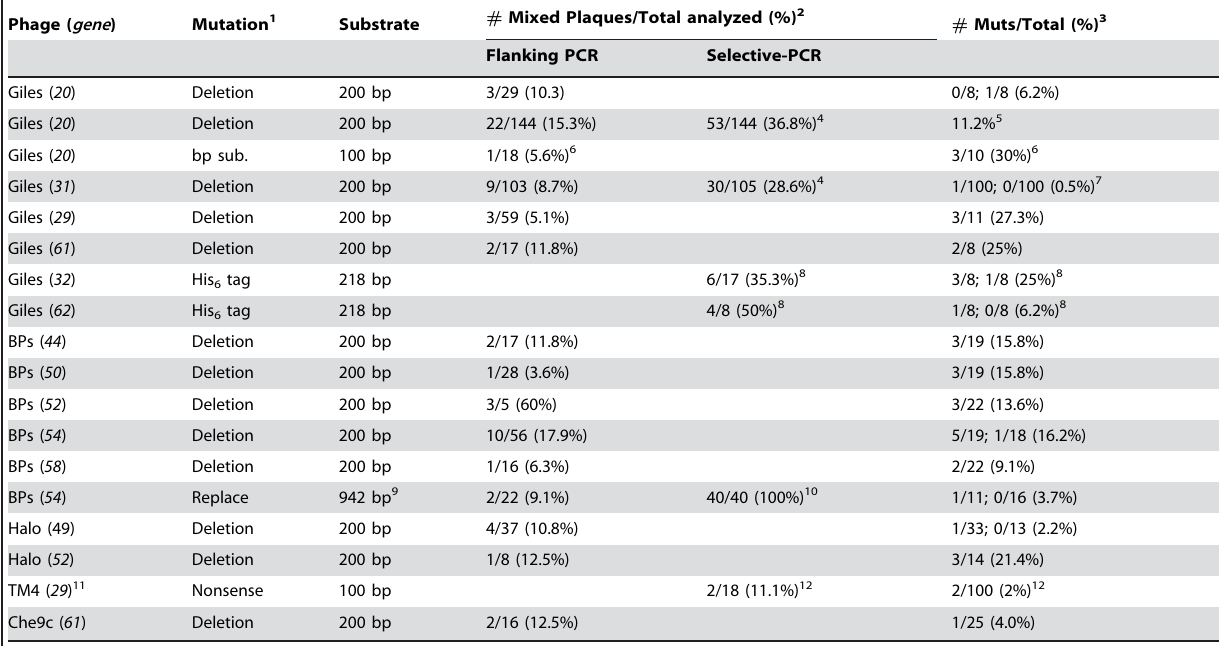
Table 3. Summary of mycobacteriophage mutants generated with